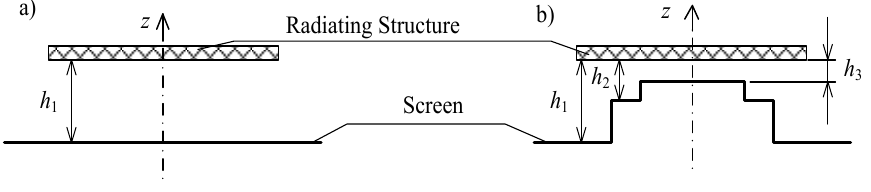
Fig. 3. Feed schematic with a flat (a) and stepped screen